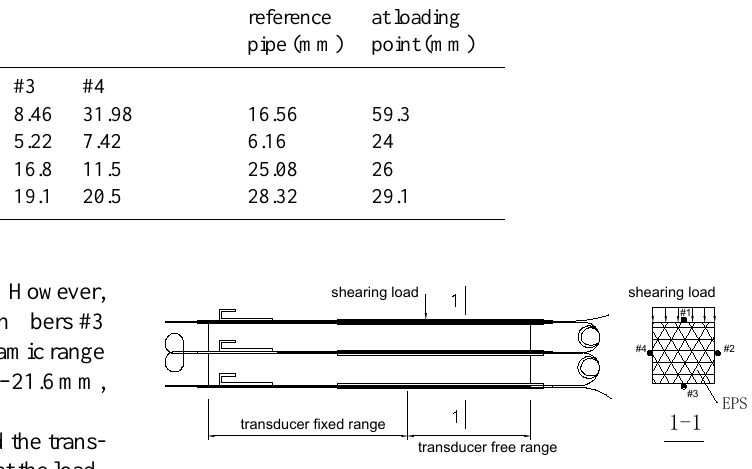
Figure 8. Diagram of the transducer subjected to shearing